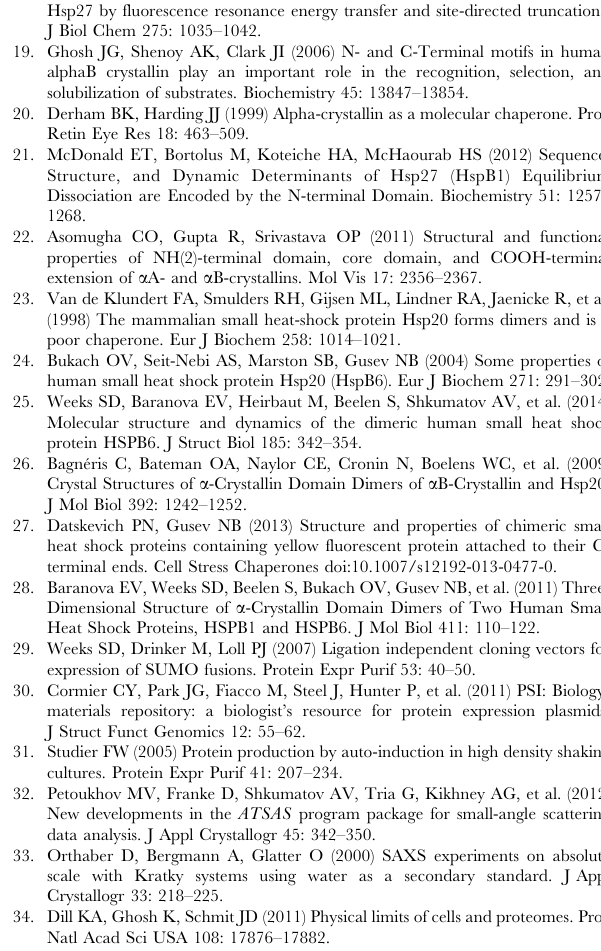
Table S1 Primers used in this work. All PCR-reactions were set up with pETHSUL-HSPB6 [55] as a